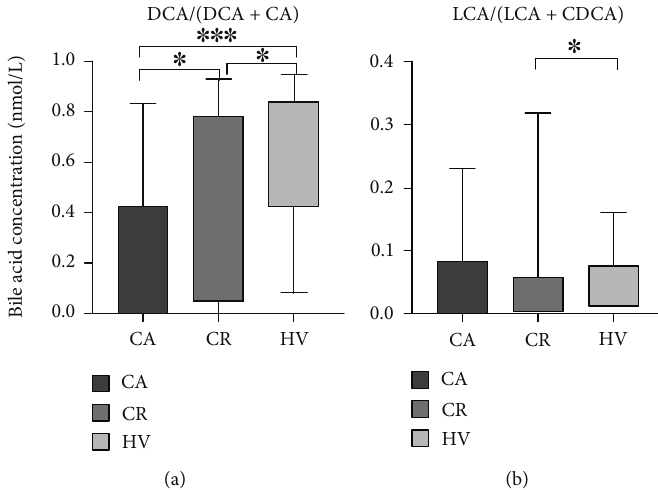
Figure 4: Comparison of serum secondary/(primary +secondary) BA ratios in the entire population. * P < 0 : 05 , ** P < 0 : 01 , and *** P < 0 : 001 .